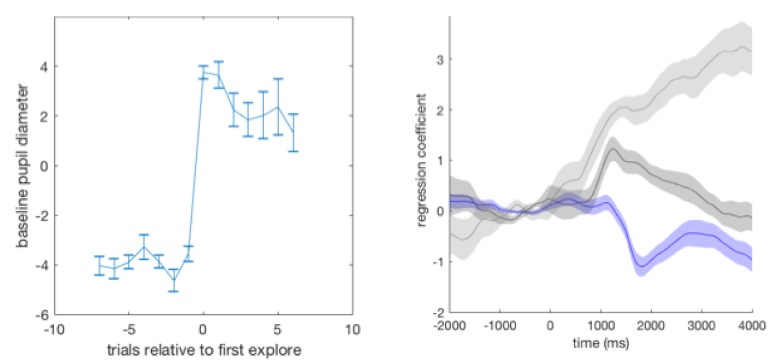
Breaking central fixation does not alter pupil effects.Figure notation the same as that in Figure 3—figure supplement 1, and analyses presented are the same, but having removed trials on which central fixation was broken. We instructed participants to maintain central fixation throughout the task. For technical reasons, the quality of the gaze location data from the fMRI session was too poor to use, so we were unable to determine whether fixation was broken. However, we did have good quality gaze location data from the behavioural session. Repeating the analyses presented in Figure 3—figure supplement 1 having removed trials containing eye movements reveals the results are qualitatively the same and quantitatively very similar to those results when trials on which central fixation was broken are not removed (as in Figure 3—figure supplement 1).